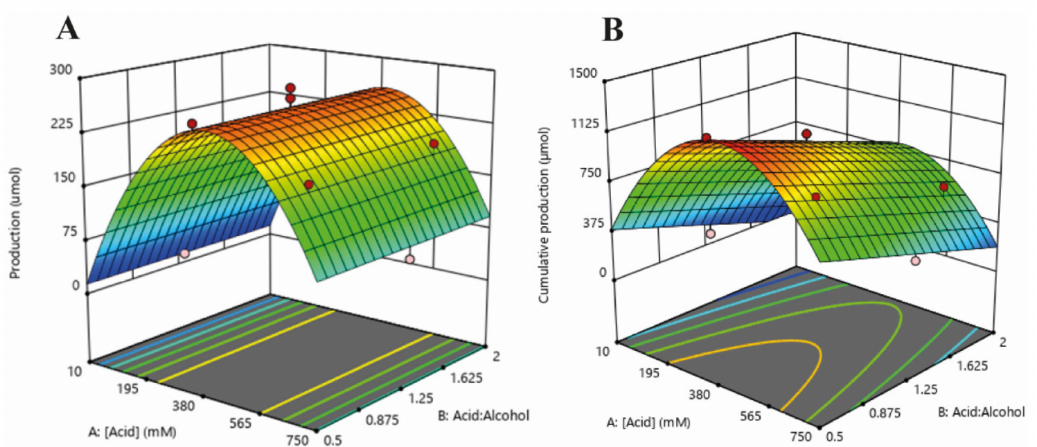
Figure 3. Experimental response surfaces for single-batch ( A ) and cumulative production ( B ) of isoamyl butyrate at different initial butyric acid concentrations and acid:alcohol mole ratios. The red dots correspond to the design points listed in Table 1. Measured values greater and smaller than the predictions are shown in dark red and light red,